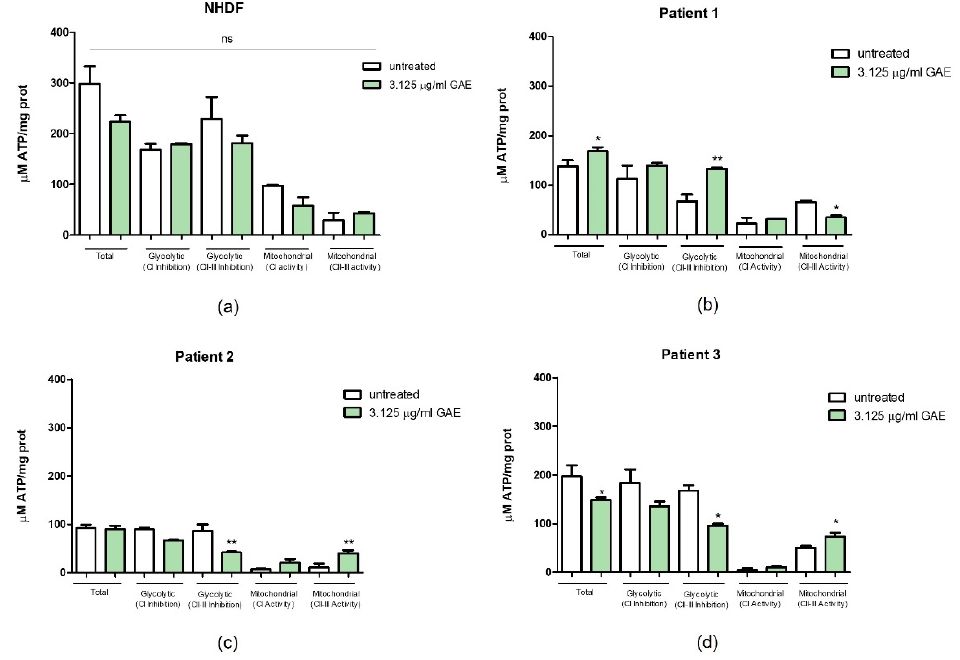
Figure 7. Effect of phenolic sumac extract on ATP production in NHDF ( a ) and PD patients ( b – d ). After 24 h treatment the production of total, glycolytic and mitochondrial ATP levels, expressed as μM ATP/mg protein (prot), was measured. All data represent the means of at least 3 replicates ± standard deviation. The analysis of variance was carried out using the One-way ANOVA test followed by the Tukey’s Multiple Comparison Test; p = ns (not significant); * p < 0.05, ** p < 0.01 were considered significant (untreated vs. treated samples). NHDF: normal human dermal fibroblast; GAE: gallic acid equivalent; CI: Complex I; CII-III: Complex